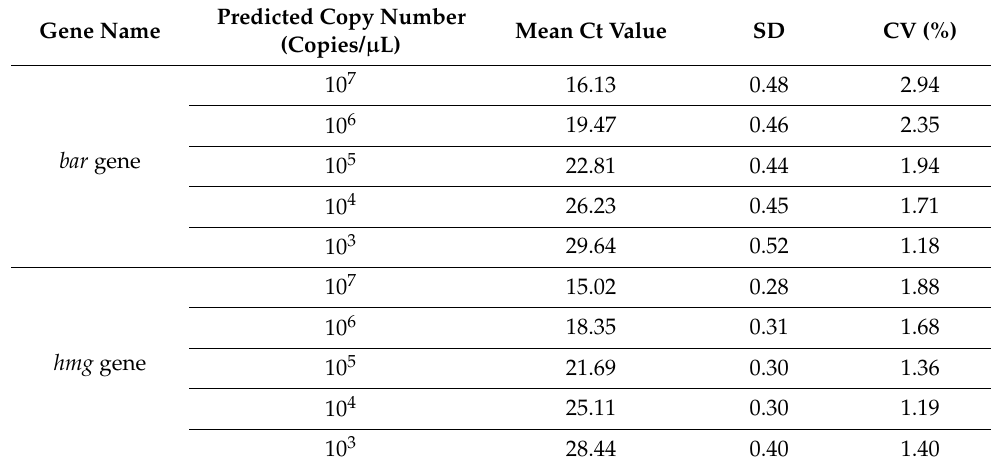
Table 2. Reproducibility of TaqMan assays for the bar and hmg